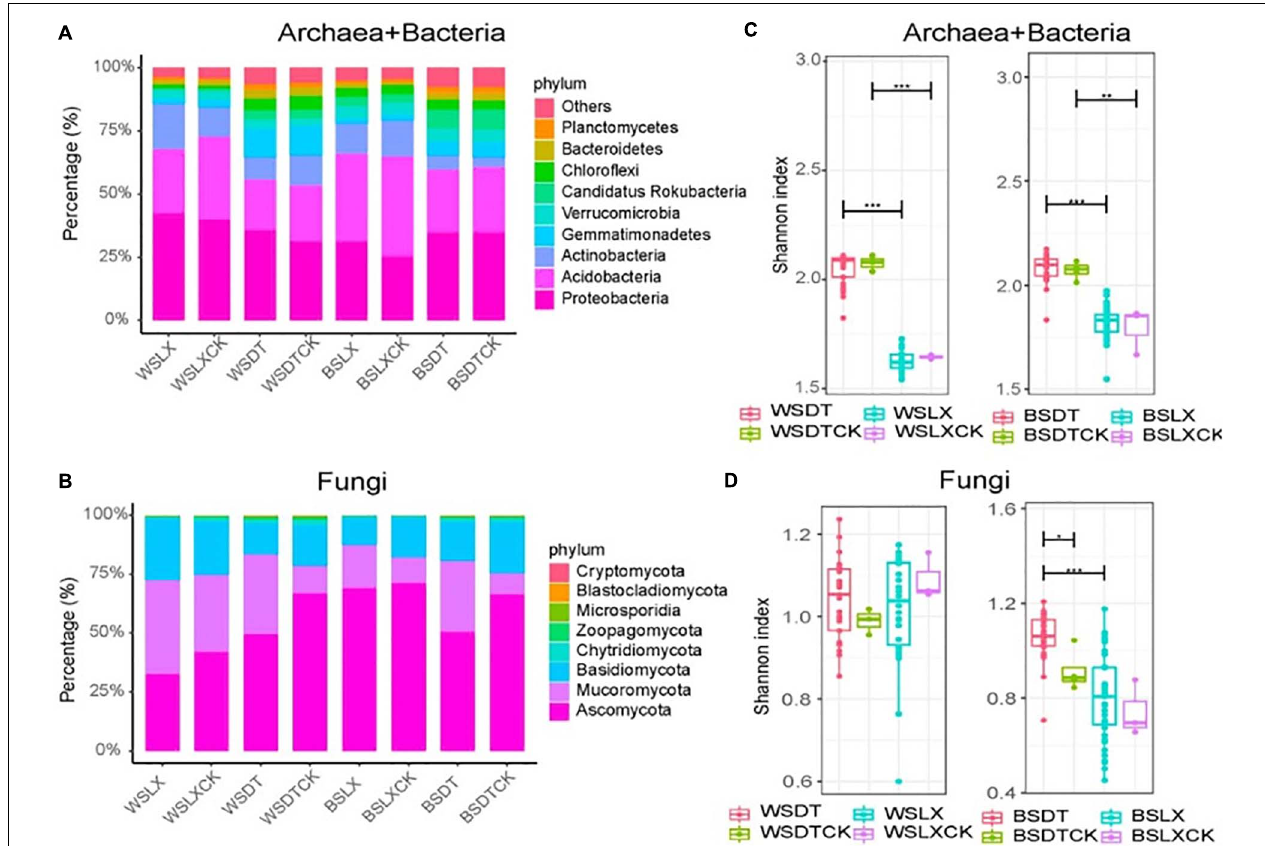
FIGURE 2 | Taxonomic distribution and diversity comparisons in P. notoginseng rhizosphere ( n = 122) and bulk soil ( n = 13) microbiomes across different sites. (A,B) Phyla-level distributions of prokaryotes and fungi in the bulk soil and rhizosphere samples based on metagenomic data. (C,D) Alpha diversity comparison between the bulk soil and rhizosphere samples from each location based on the Shannon index using the metagenomic data; * P < 0.05; ** P < 0.01; *** P < 0.001. One-sided t -test; center value represents the median of the Shannon index. WSDT, rhizosphere soil of cropland planting in Wenshan city; WSDTCK, bulk soil of cropland planting in Wenshan City; WSLX, rhizosphere soil of understory planting in Wenshan City; WSLXCK, bulk soil of understory planting in Wenshan City; BSDT, rhizosphere soil of cropland planting in Baise City; BSDTCK, bulk soil of cropland planting in Baise City; BSLX, rhizosphere soil of understory planting in Baise City; BSLXCK, bulk soil of understory planting in Baise